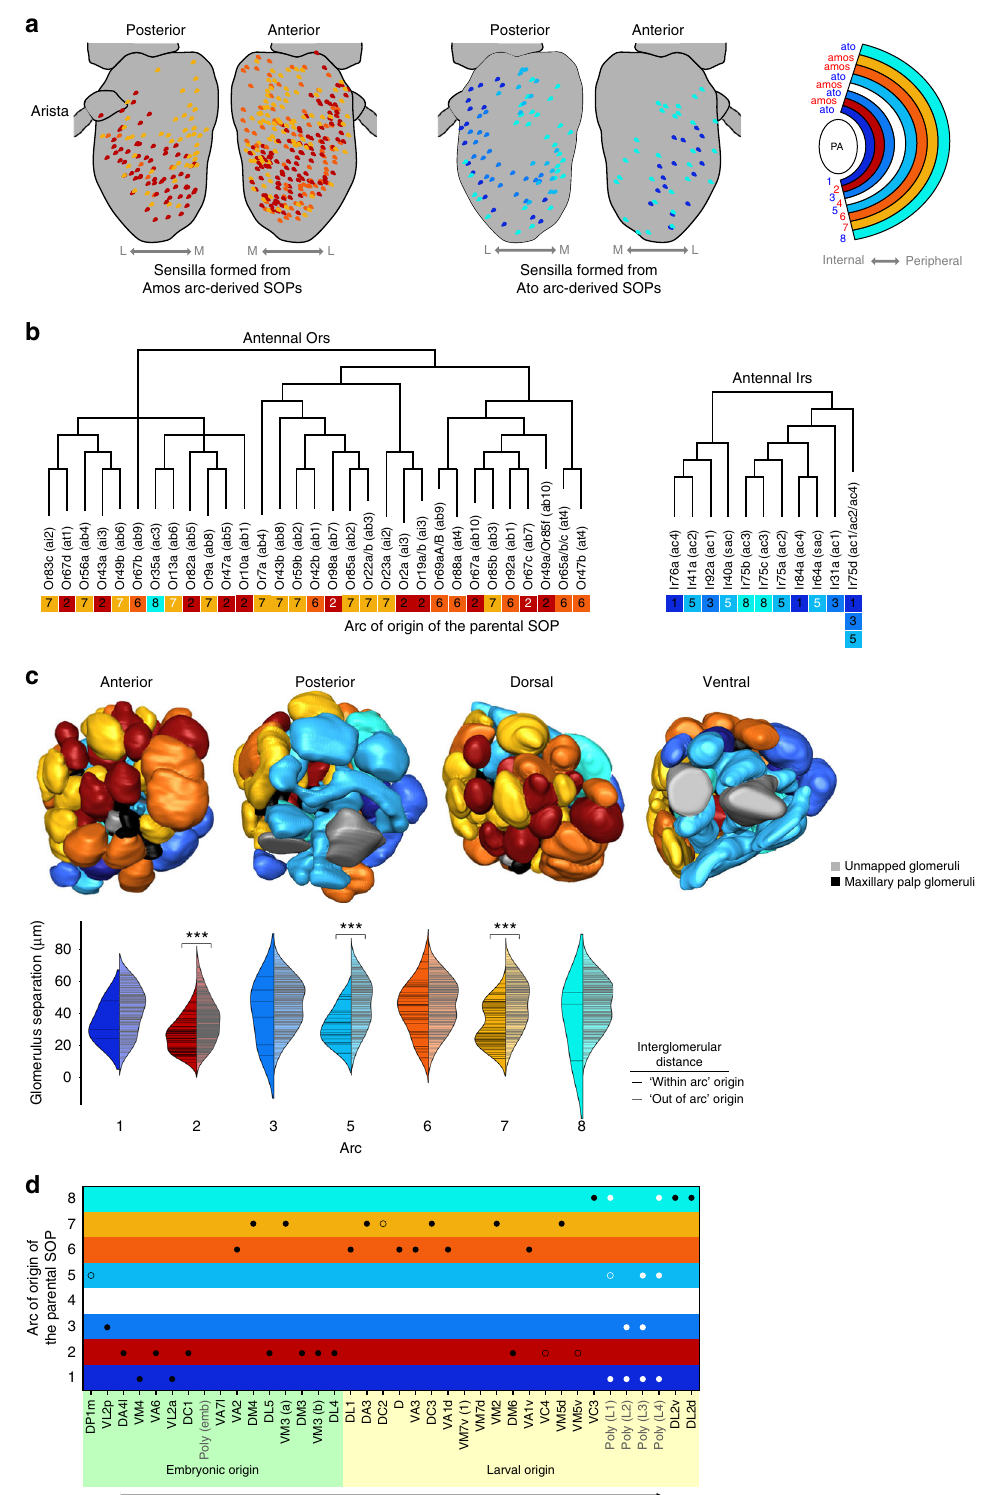
The duplication of Or67d neurons in pnt RNAi antennae observed with the GFP reporter was validated by direct visualization of Or67d mRNA expression (Fig. 7c). Further- more, we con fi rmed this RNAi phenotype through analysis of a pnt loss-of-function mutation, by using MARCM 44 to generate GFP-labeled wild-type or pnt mutant OSN clones, which were examined for Or67d mRNA